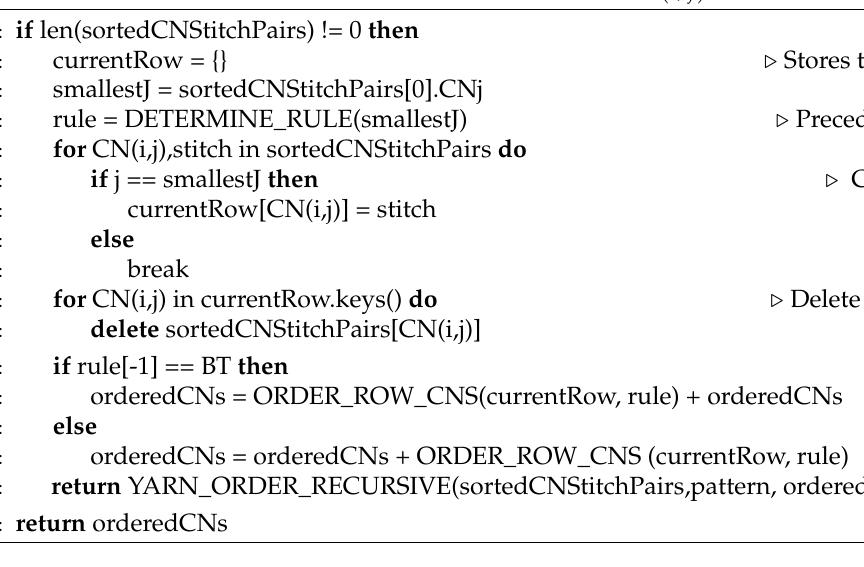
Algorithm 4 YARN _ ORDER _ RECURSIVE ( sortedCNStitchPairs , pattern , orderedCNs ) Recursive function used to define the order of CNs at location ( i , j )